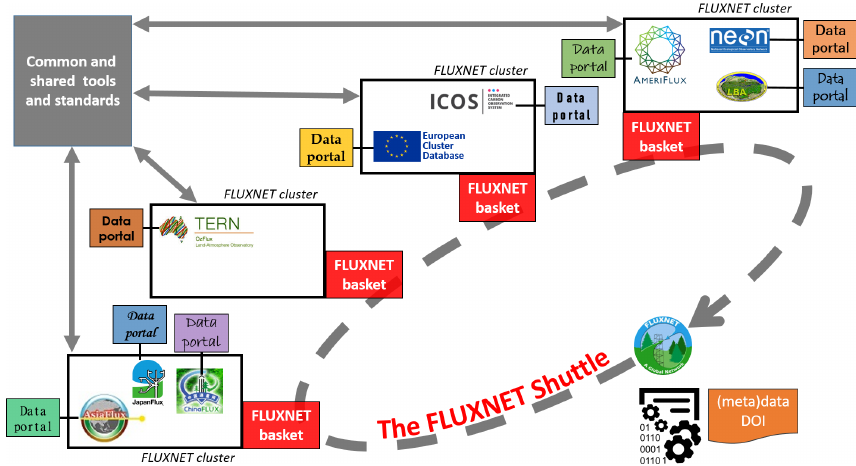
Figure 1. Scheme of the proposed new organization of FLUXNET for data collection preparation (see text). “Data portal” boxes represent the regional or national network databases, all potentially different in terms of data processing, format and data policy. The black boxes grouping regional or national networks are the “FLUXNET cluster”, the framework under which a set of national networks coordinate their participation in FLUXNET and to which a common processing is applied. “FLUXNET basket” red squares are the database sections for FLUXNET data to share, in which a common format of data and metadata is loaded whenever ready and distributed under the same common data policy. “FLUXNET shuttle” is the tool to access the data across the FLUXNET clusters that is run on demand by the users and provides a dataset (including metadata) and a PID or DOI for the exact citation and reconstruction of the dataset used.